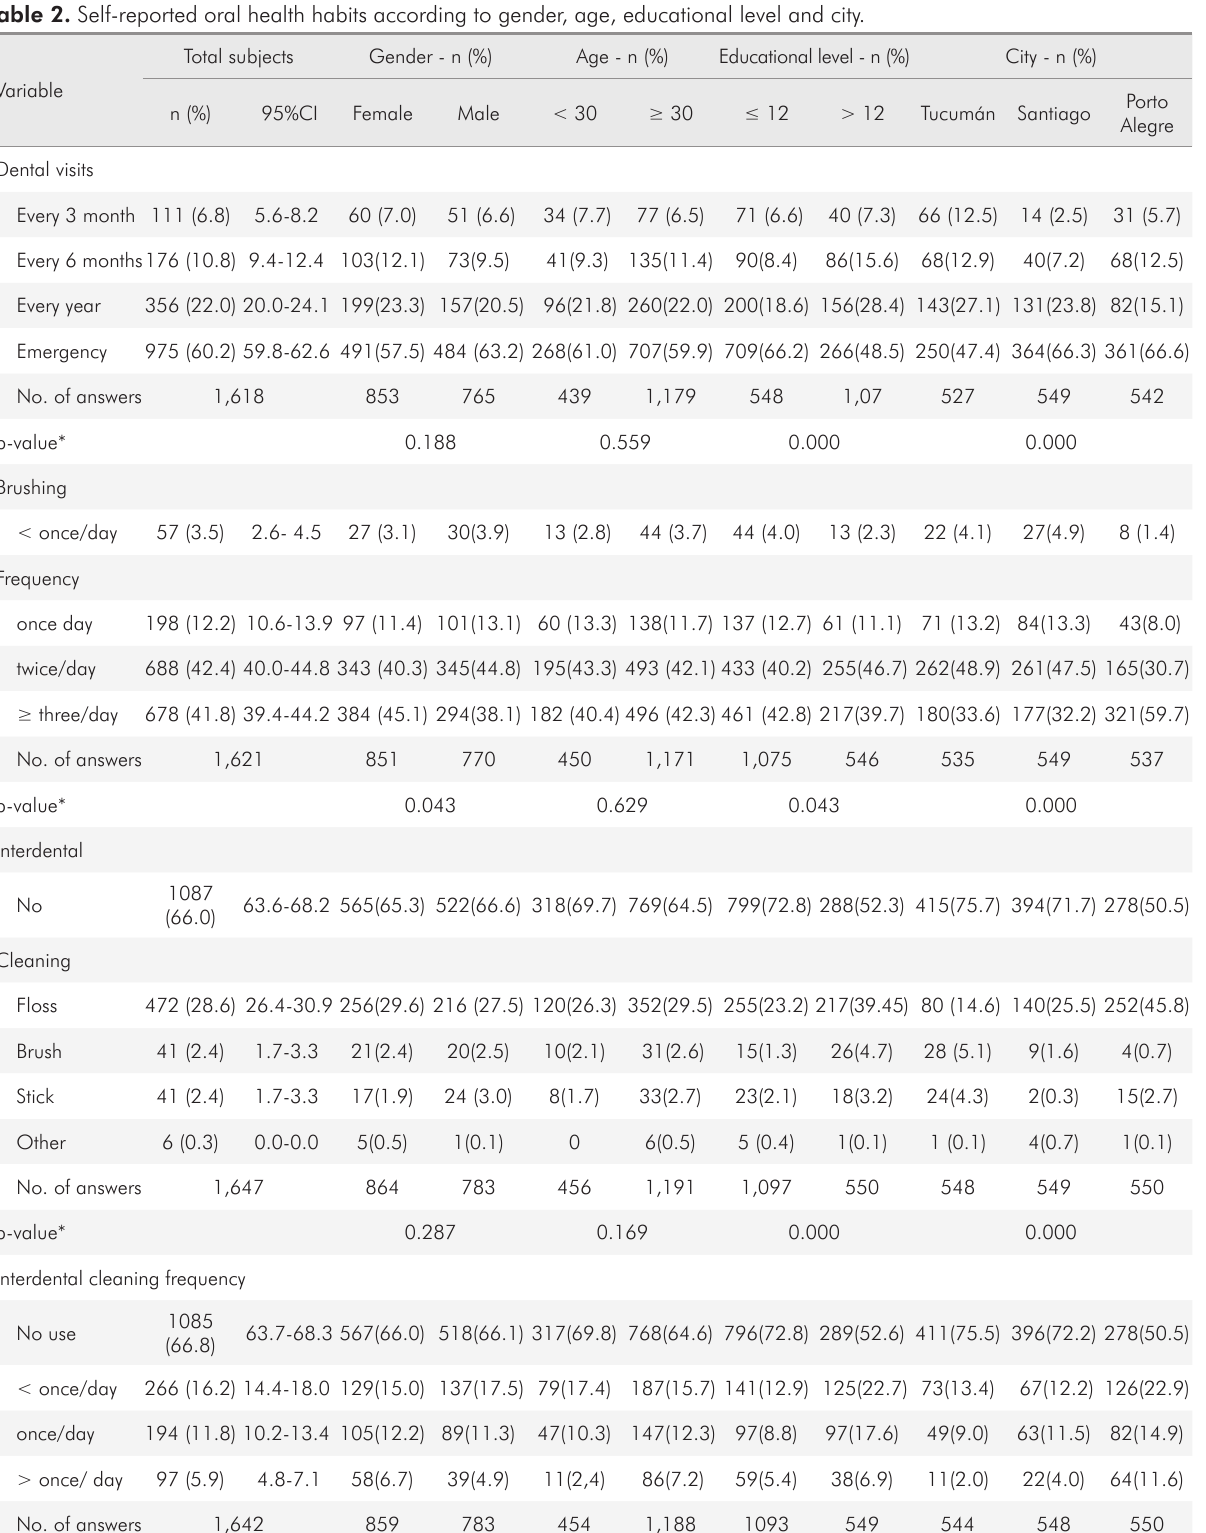
Table 2. Self-reported oral health habits according to gender, age, educational level and city.